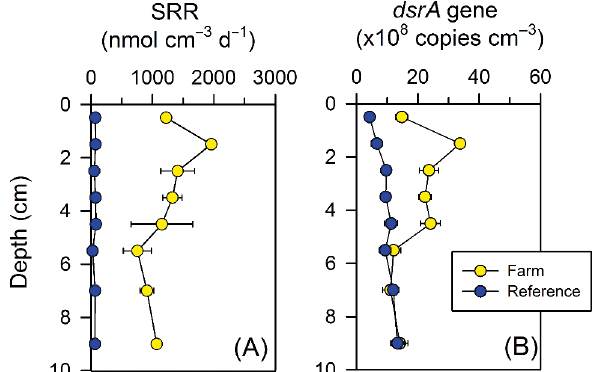
Fig. 3. Vertical distributions of (A) sulfate reduction rate (SRR) and (B) DNA copy number of the dsrA gene at farm and reference